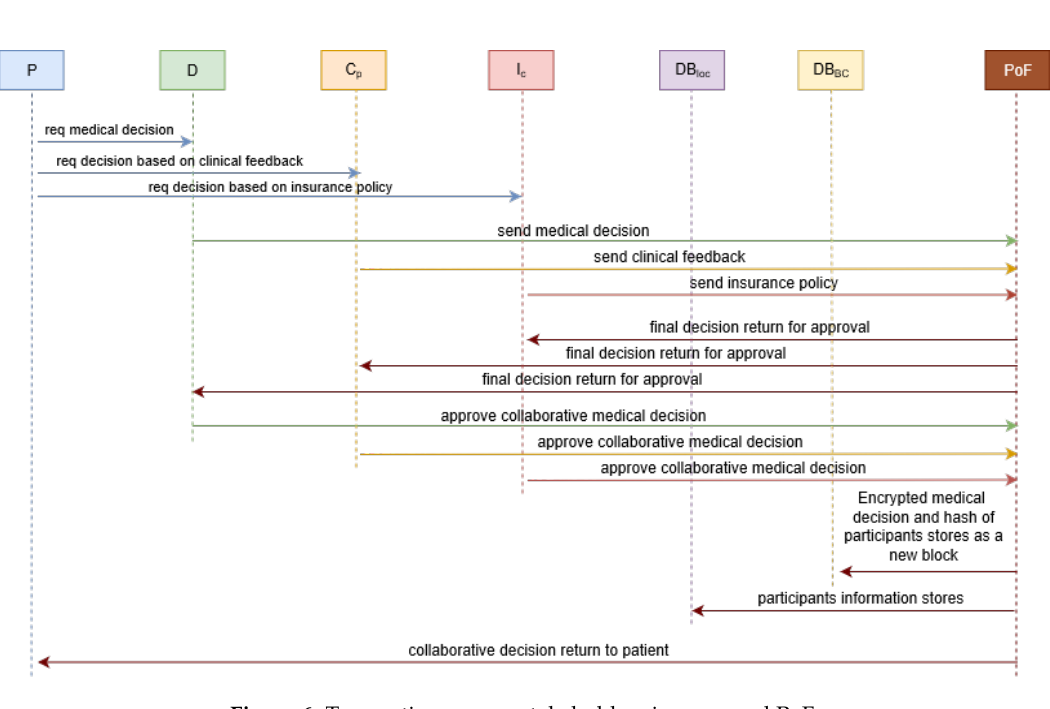
Figure 6. Transaction among stakeholders in proposed PoF.